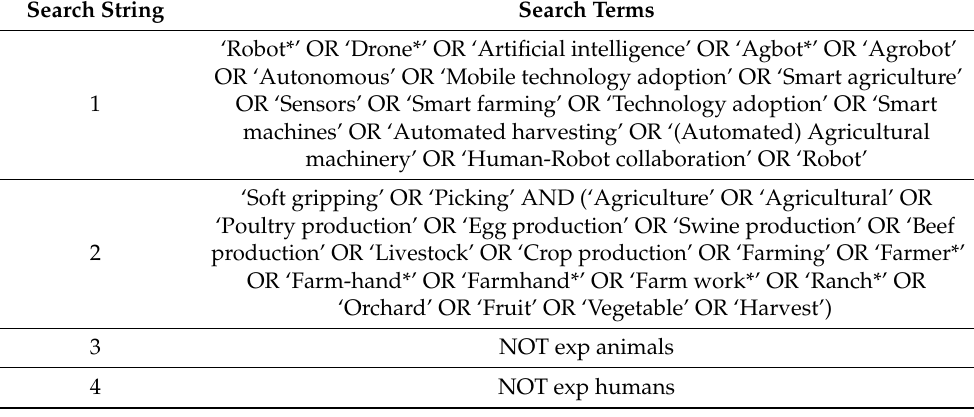
Table 1. Search strings used to identify articles.